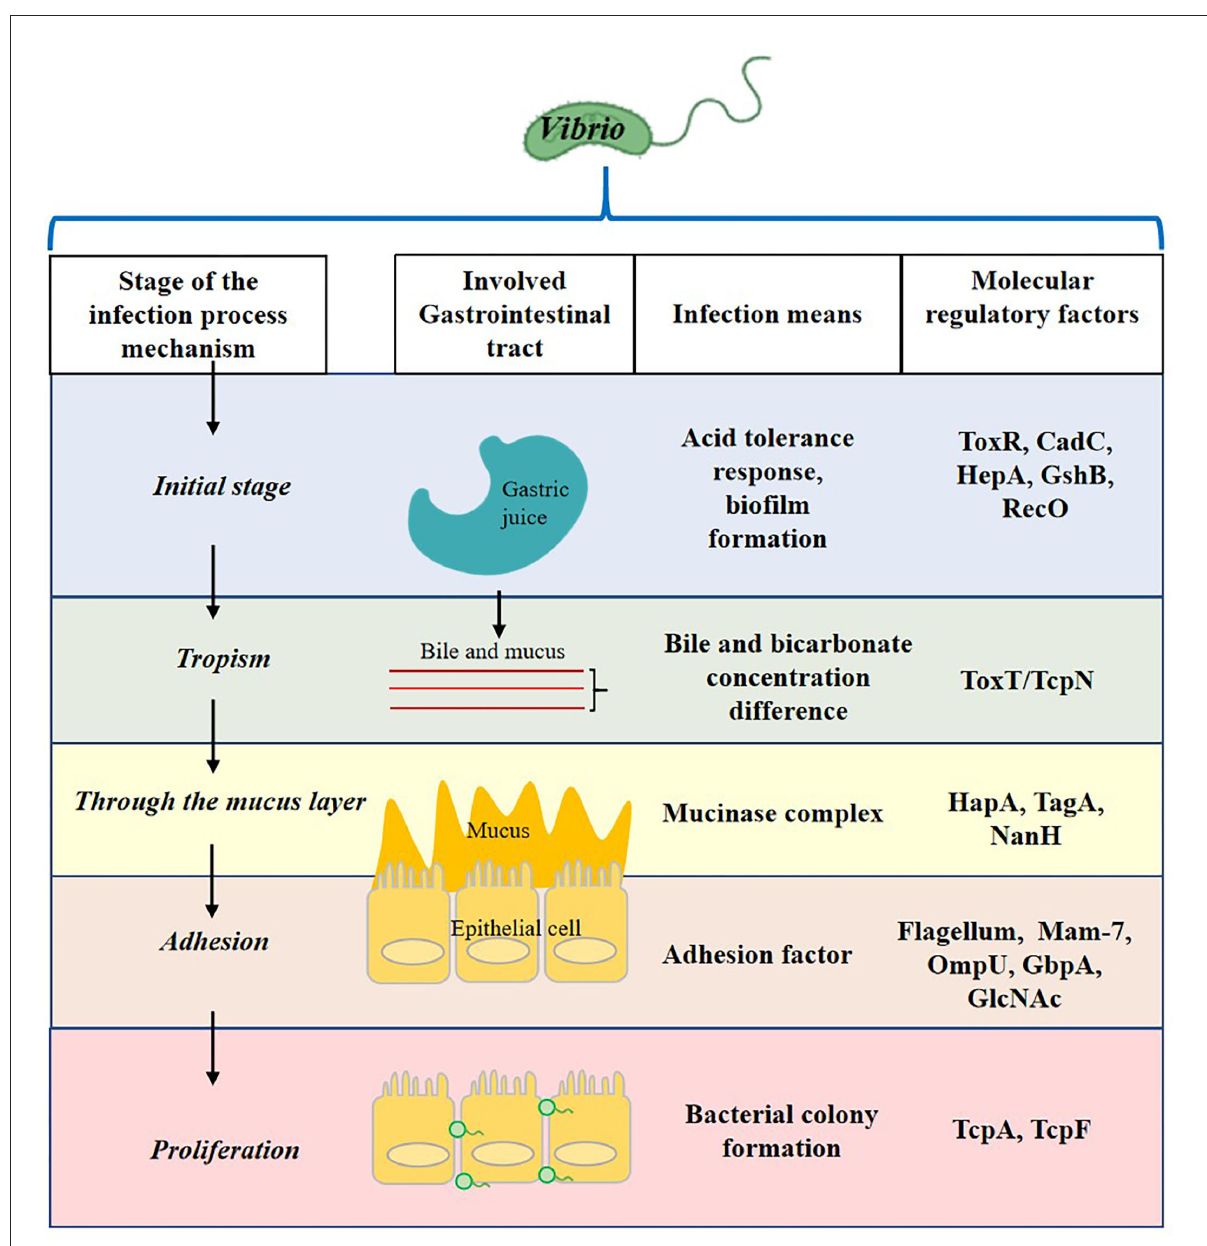
FIGURE1 The involved gastrointestinal tract, infection means, and molecular regulatory factors of the Vibrio infection